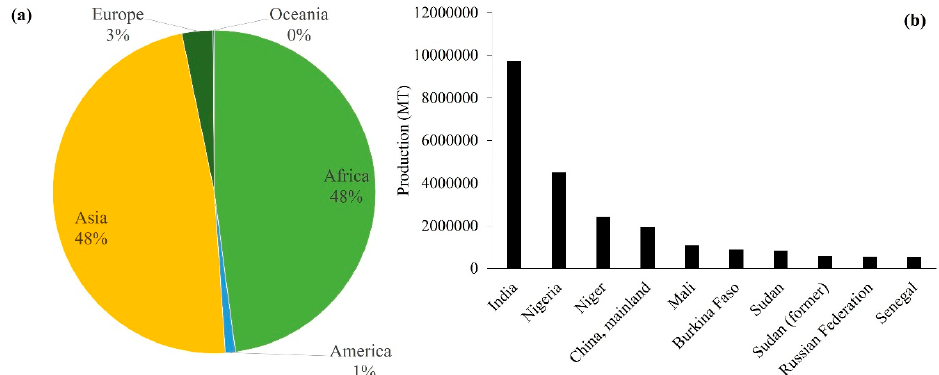
Figure 1. ( a ) Global millet production. ( b ) The world’s top 10 millet producers. India, African countries and China dominate the production scale. (*Production units are in Metric Tons (MT)).